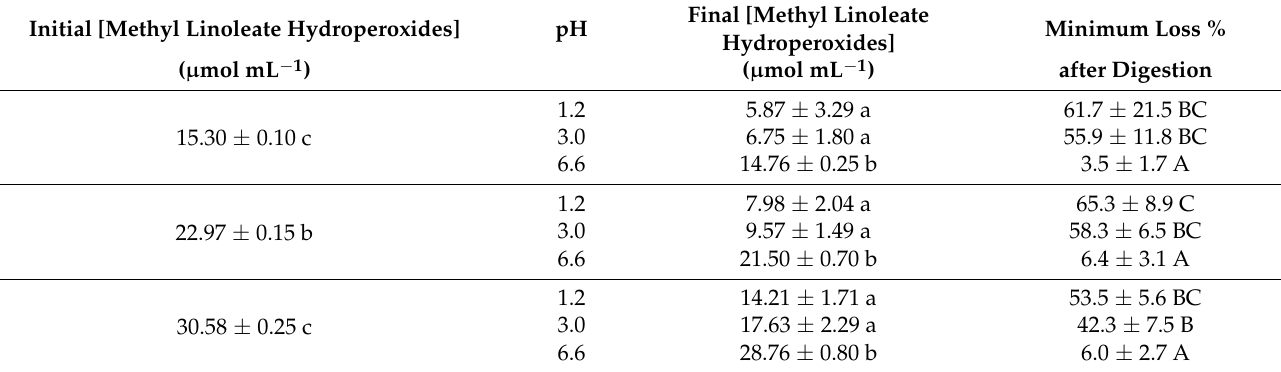
Results are expressed as means ± SD ( n = 3). Different letters indicate significant differences according to Tukey ´ s test at p < 0.05. Different lowercase letters in concentration values indicate significant differences between samples of the same initial concentrations. Different uppercase letters in minimum loss percentage calculations indicate significant